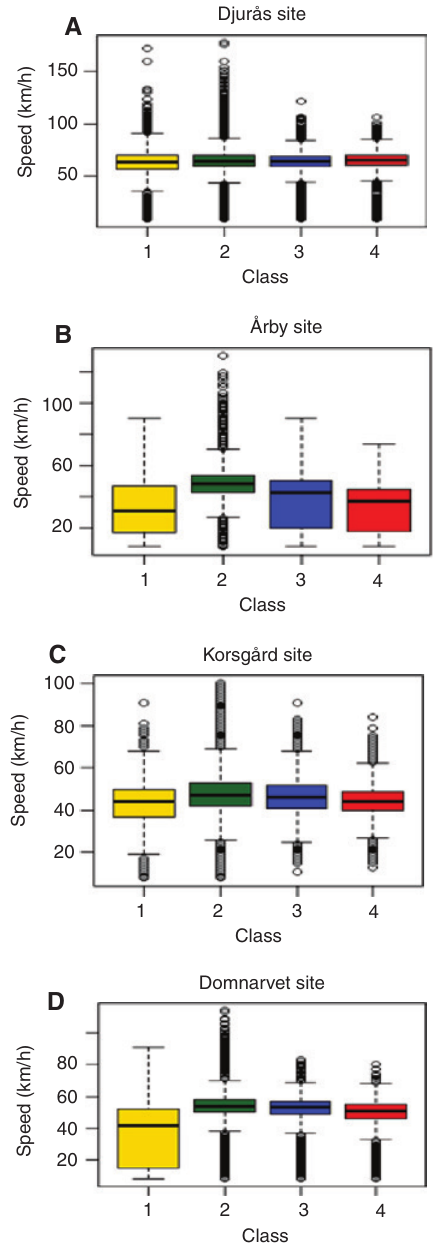
Figure 2: Boxplot Comparisons of the Four Classes at Four Test Sites: (A) Site-1, (B) Site-2, (C) Site-3, and (D)